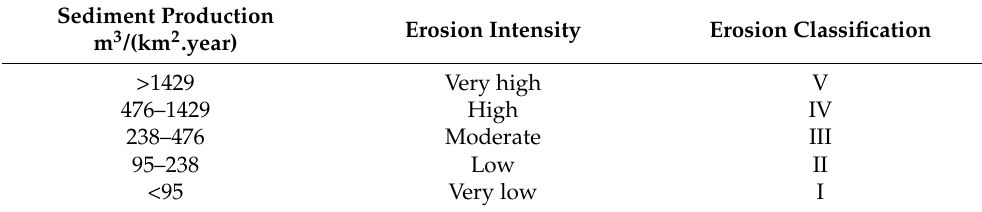
Table 3. Classification of soil erosion in MPSIAC